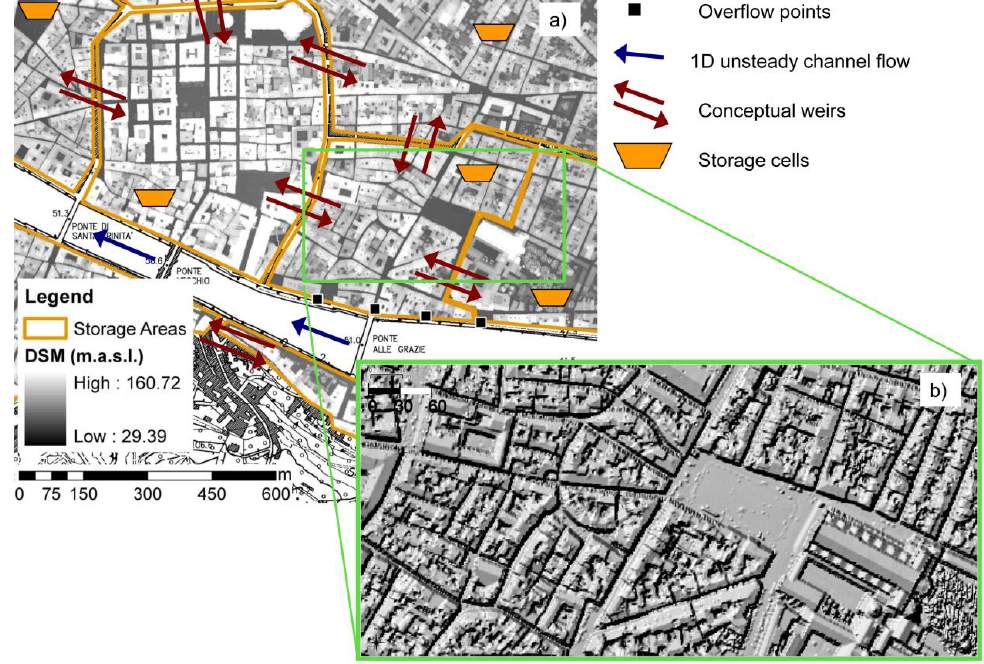
Fig. 2. Scheme of the quasi-2-D hydraulic model (a) , superimposed on the digital surface model (DSM) of the downtown study area of Florence and a zoom of the St. Croce area with a hillshade effect (b) Figure 2. Scheme of the quasi-2D hydraulic model (a), superimposed on the Digital Surface 3 Model (DSM) of the downtown study area of Florence and a zoom of the S. Croce Area with 4 a hillshade effect (b). 5